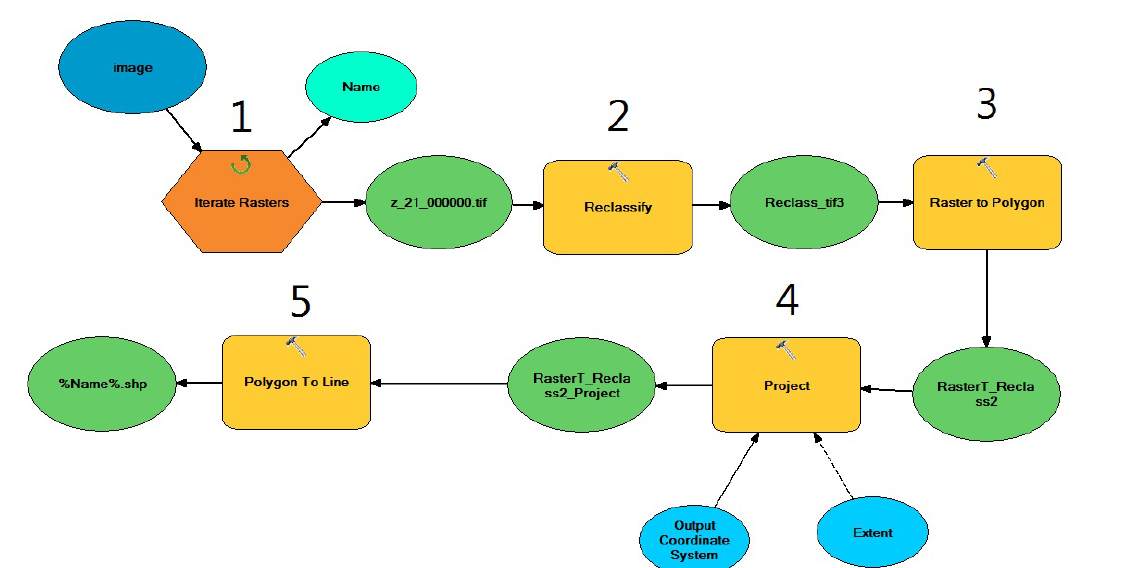
Figure 2. Flowchart of extracting coastal line for all output file near Chabahar port (15 meters resolution). According to this Figure, 1. Iteration must be dong for whole output file, 2. Reclassify each output data to extract the value of sea deformation data (deletion Null data), 3. Convert each output data (raster) to polygon, 4. Checking extent and coordinate system, 5. Convert of each polygon to line; extracting boundary line (coastal